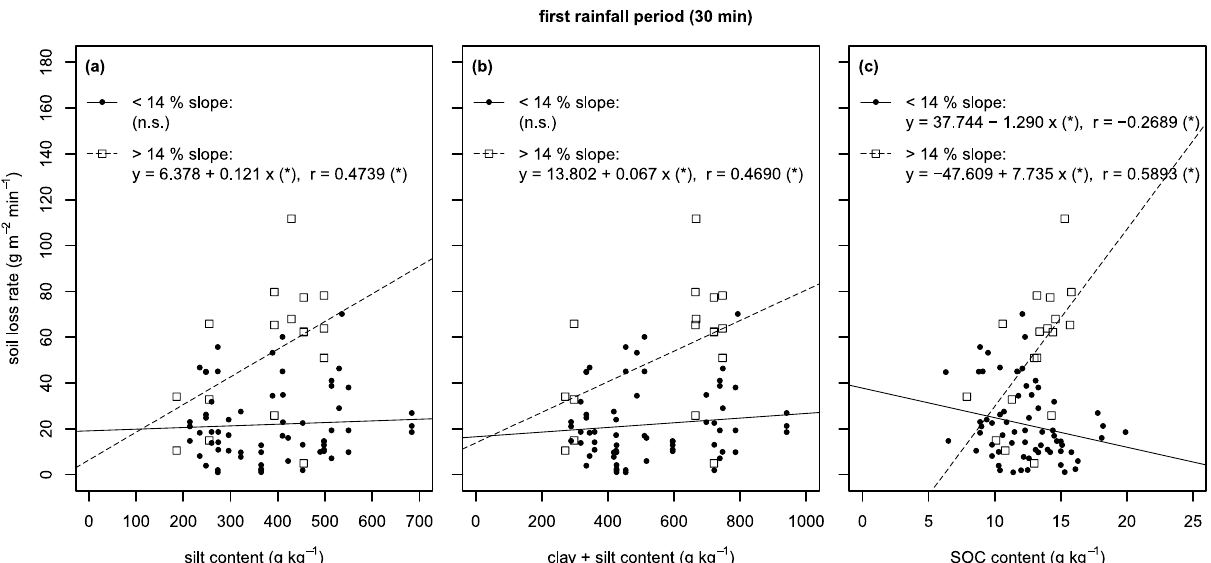
Figure 4. Simple linear regression of the soil loss rate in the first rainfall period (30 min) against ( a ) the silt content, ( b ) clay + silt content, and ( c ) soil organic carbon (SOC) content. For the parameter fittings of sites with < 14% slope inclination, generalised linear models assuming a Gamma distribution have been applied. The regression functions and Pearson product–moment correlation coefficients ( r ) are given for the significant parameter fittings. The significance levels of the regression function slopes and r , indicating a difference from zero, are as follows: (*) p < 0.05; (n.s.) not significantly different at p < 0.05.